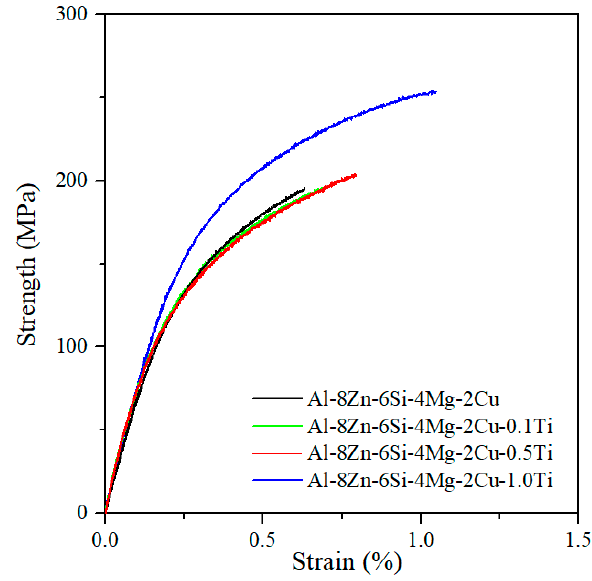
Figure 9. Stress-strain curve of Al-8Zn-6Si-4Mg-2Cu alloys with different Ti contents.